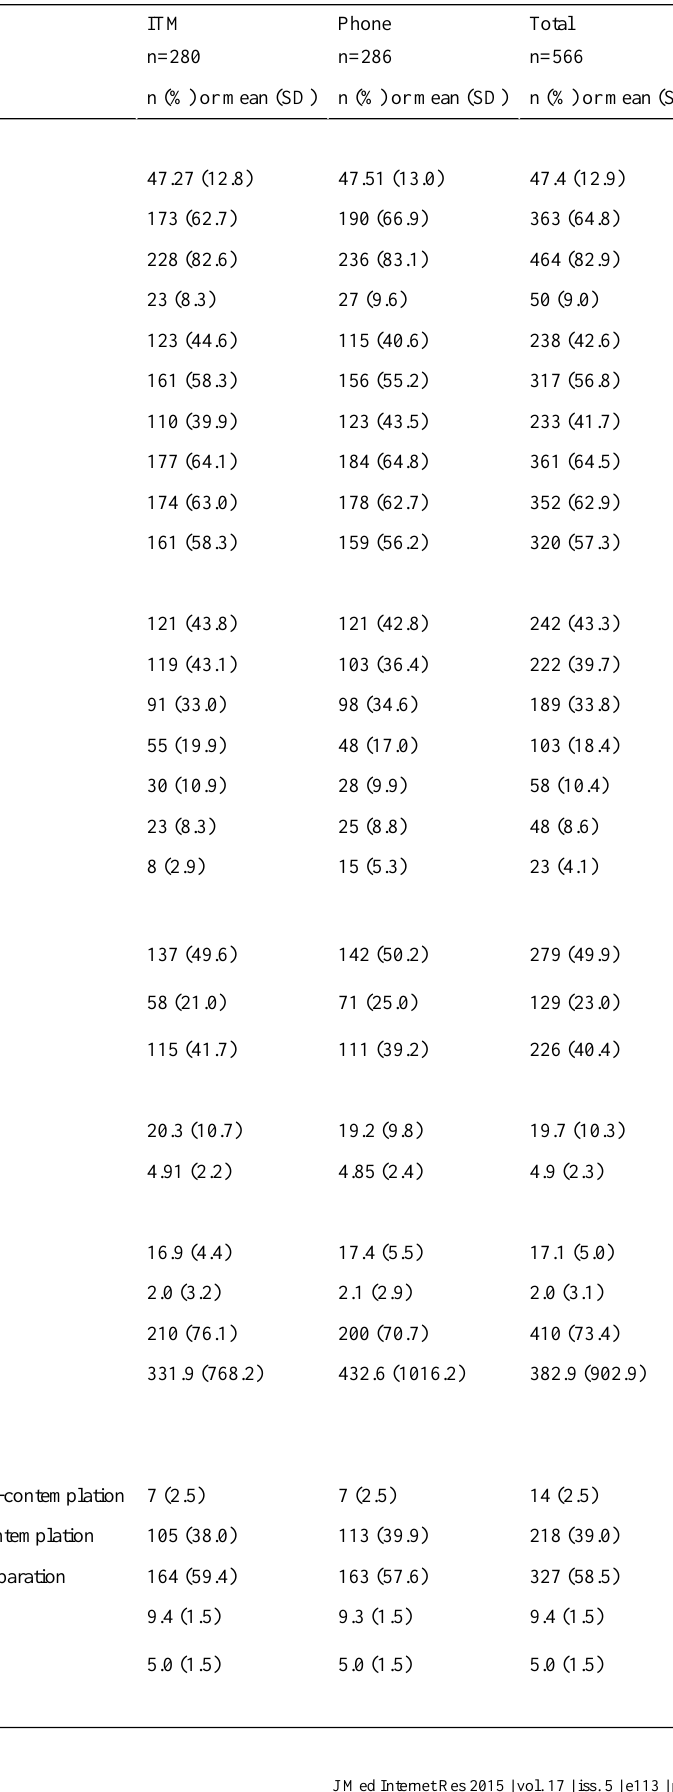
Table 1. Baseline